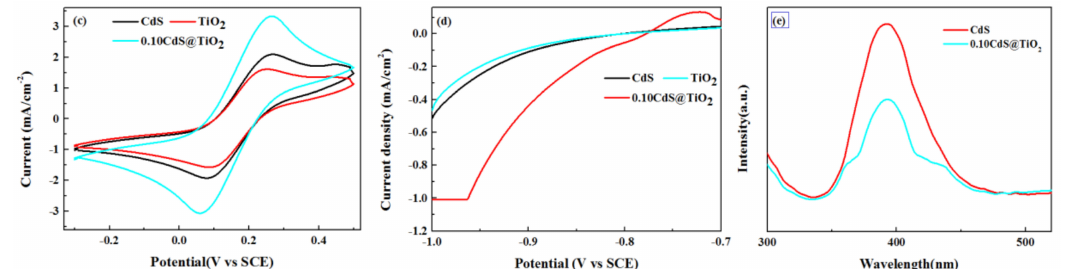
Figure 3. Transient photocurrent response of samples ( a ); electrochemical impedance spectra of CdS, TiO 2 , CdS@TiO 2 ( b ); cyclic voltammogramof CdS, TiO 2 , CdS@TiO 2 ( c ); linear-sweep voltammograms of CdS, TiO 2 , CdS@TiO 2 ( d ); photoluminescence spectra of CdS, TiO 2 , CdS@TiO 2 ( e ).